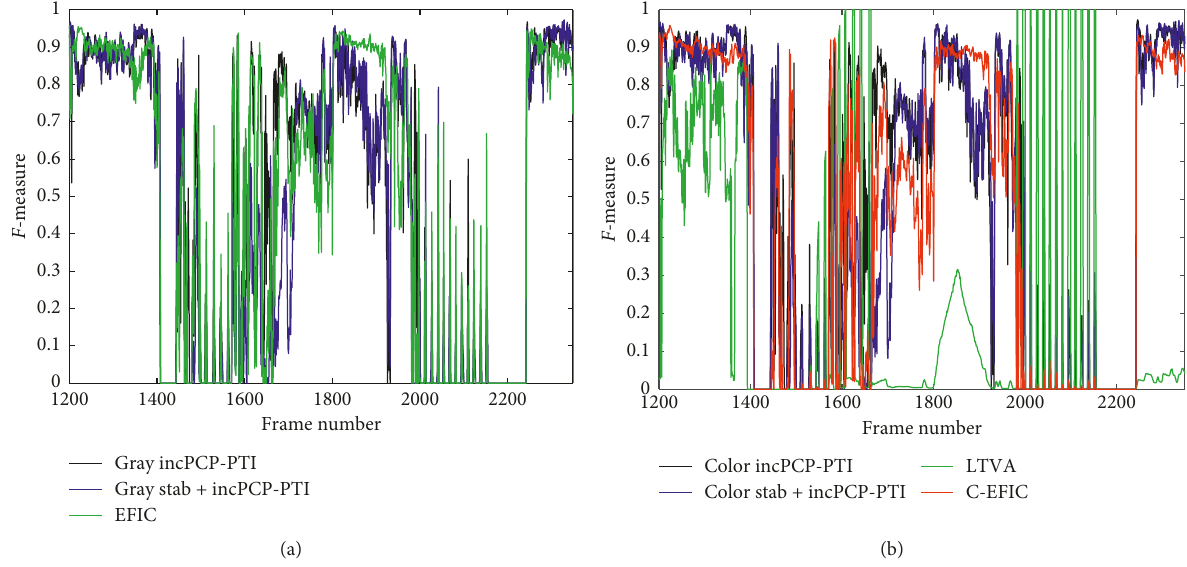
Figure 11: F measure per frame for the IP video for the grayscale-based methods (a) and color methods (b). Note: they are shown only for available frames (restriction of dataset). This figure is a slightly modified version of Figure 9 of [28]. Table 5: Value of F measure for grayscale and color incPCP-PTI and for EFIC and C-EFIC on the CP video.